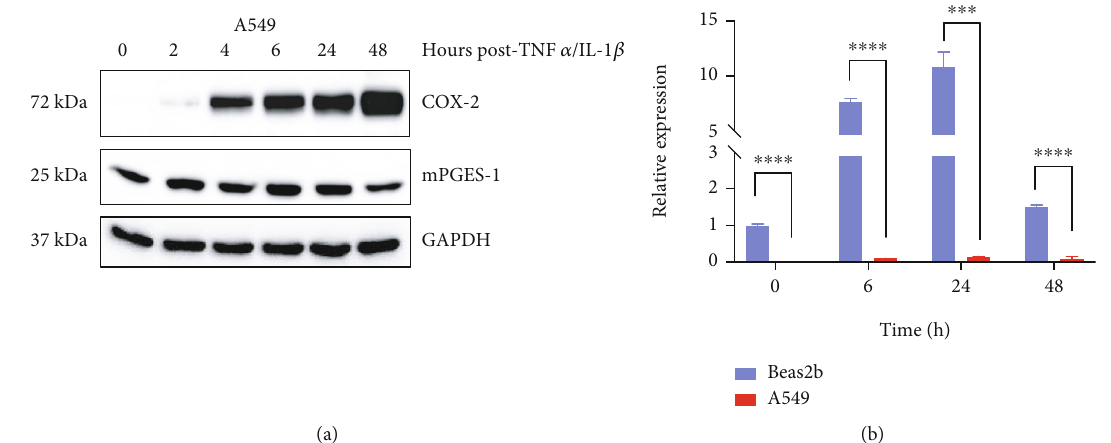
Figure 2: miR-708 and AA signaling regulation is uncoupled in TNF α /IL-1 β -modulated diseased lung cells. (a) Representative western blot of COX-2 and mPGES-1 protein expression from 0 to 48 hours after TNF α /IL-1 β exposure in A549 cells. GAPDH served as a loading control. (b) RT-qPCR of mature miR-708 in Beas2b (blue, nondiseased) and A549 (red, diseased) cells 0 – 48 hours post-TNF α /IL-1 β exposure. miR-708 expression was normalized to U6 snRNA and analyzed using the 2 - ΔΔ CT method. ∗∗∗ p < 0 : 001 and ∗∗∗∗ p < 0 : 0001 , n = 3 (Figure 2(a)). Conversely, we saw nonsigni fi cant TNF α /IL- 1 β -induced increases in miR-708 expression in A549 cells (Figure 2(b) p = n : s : , n = 3 ). When paired with Beas2b miR- 708 expression changes, we see that A549 miR-708 levels are signi fi cantly lower at baseline (Figure 2(b), p < 0 : 0001 , n = 3 ). We have previously shown that reduced miR-708 expression in A549 cells is due to ODZ4 promoter methyla- tion [18]. Moreover, A549 miR-708 levels never increased above 15% of baseline Beas2b expression after TNF α /IL-1 β treatment, and miR-708 levels are signi fi cantly lower at every time point in A549 cells (Figure 2(b), p < 0 : 001 , n = 3 ). These data suggest that ODZ4 promoter methylation prevents TNF α /IL-1 β -induced miR-708 expression, disconnecting the